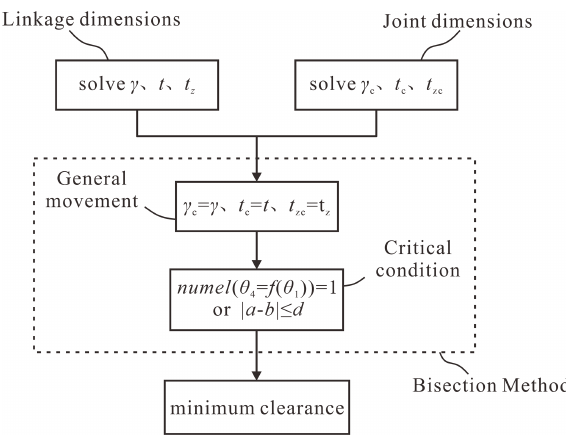
Figure 8. The flowchart of minimum clearance.